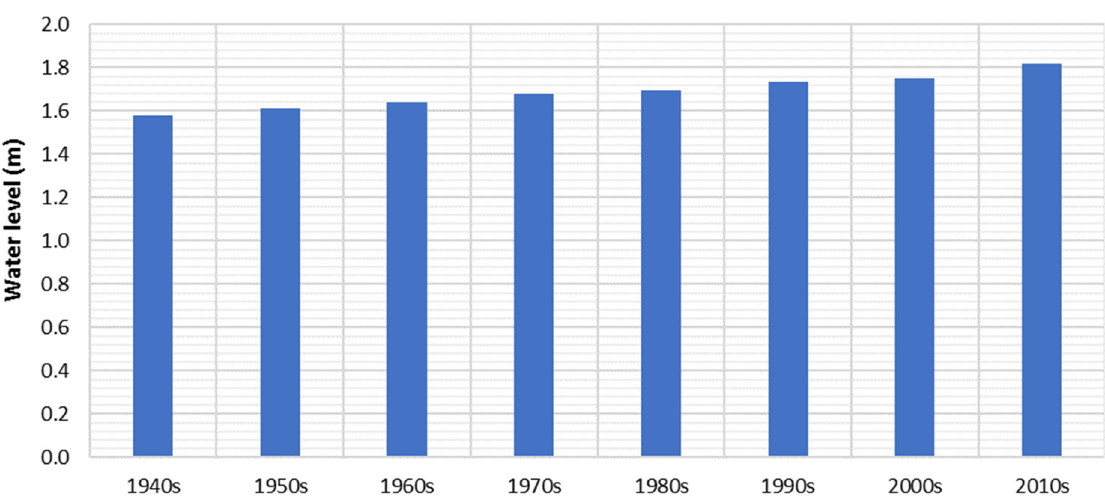
Figure 4. Average decadal sea level at Charlottetown, PEI.